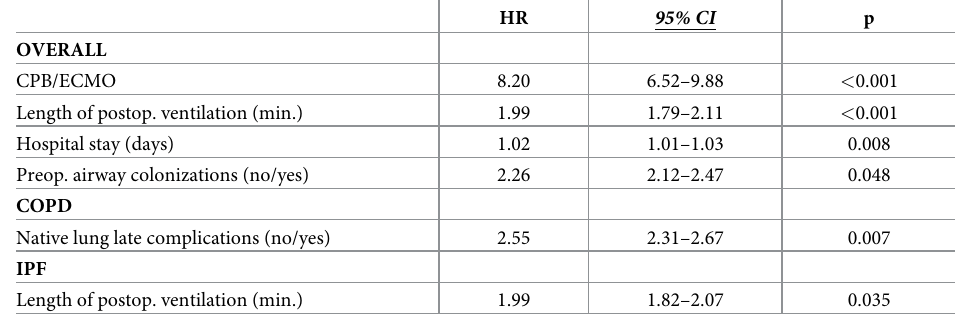
Table 3. Factors predictive of survival in the overall group, stratified by indication of lung transplantation. HR 95% CI p OVERALL CPB/ECMO 8.20 6.52–9.88 < 0.001 Length of postop. ventilation (min.) 1.99 1.79–2.11 < 0.001 1.02 1.01–1.03 0.008